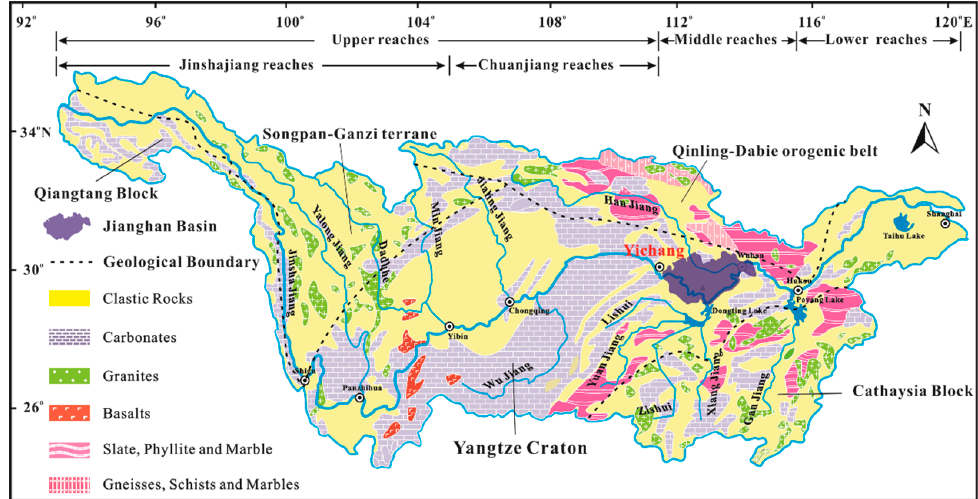
Figure 2. Geological map of the Yangtze River Basin (modified after Shao et al., 2012 [9]).